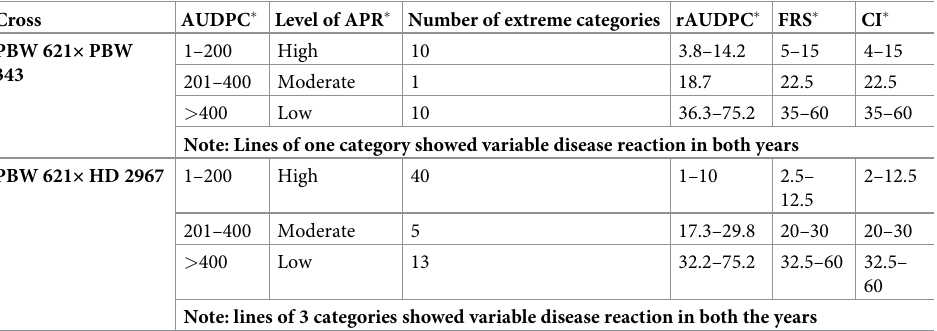
Table 2. Categorization of extreme phenotypic categories of 2 crosses (PBW 621 × PBW 343 and PBW 621 × HD 2967) based on AUDPC � (2016–17 and 2017–18).